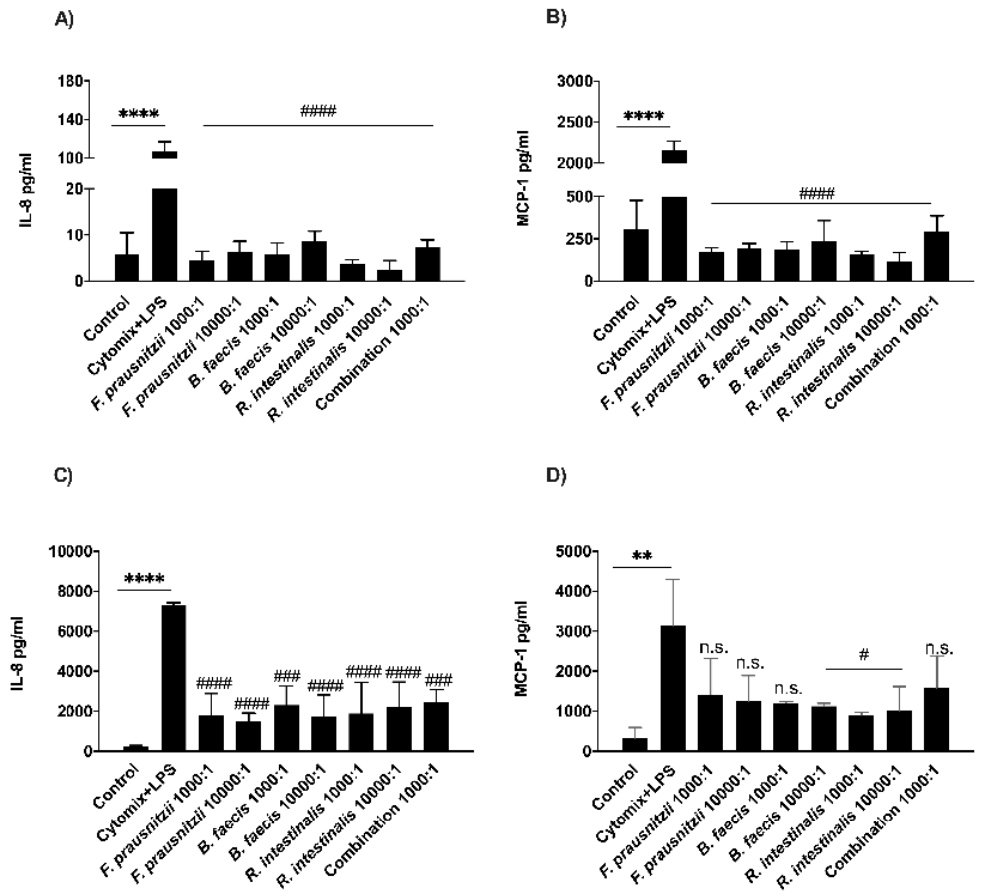
Figure 4. The secretion of IL-8 and MCP-1 in the inflamed Caco-2 and HT29-MTX monolayers. Epithelial cell monolayers were treated with cytomix + LPS following the incubation with bacteria individually or in combination for 6 h. Culture media sample was collected from the basal compartment. The concentration of IL-8 and MCP-1 secreted by Caco-2 ( A , B ) and HT29-MTX ( C , D ) cells were measured by multiplex flow cytometric bead array assay. ** p ≤ 0.01, **** p ≤ 0.0001 compared to the control, # p ≤ 0.05, ### p ≤ 0.001, #### p ≤ 0.0001, n.s., no statistical significance compared to cytomix + LPS, as determined by one-way ANOVA and presented as means ±SD (n = 3). 3.7. Immunofluorescence Microscopic Localization of Tight Junction Proteins The